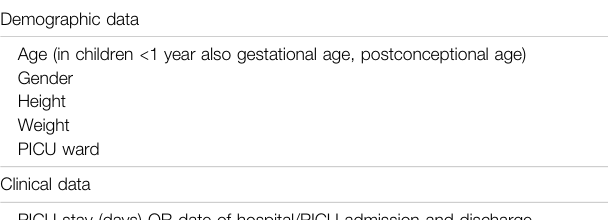
TABLE 2 | List of variables captured in the EXPAT Kids